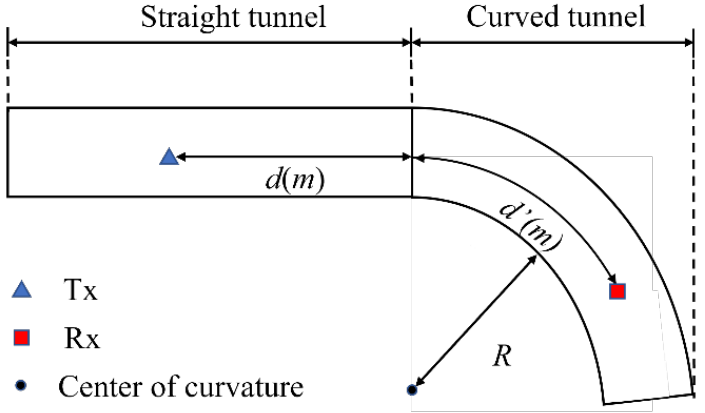
Figure 1. Cascaded tunnel and antenna locations.